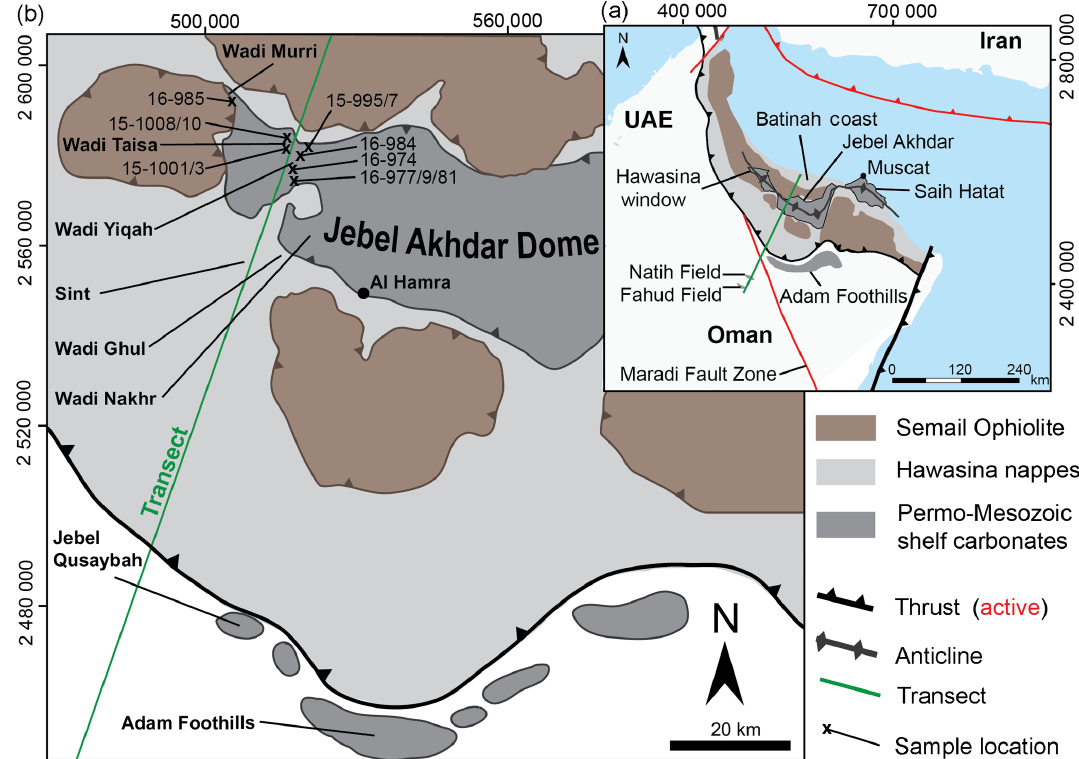
Figure 1. (a) Tectonic setting of the Oman mountains. In dark gray are the three tectonic windows of Hawasina, Jebel Akhdar, and Saih Hatat, as well as the Adam Foothills. Brown areas show the exposed Semail Ophiolite, black lines denote the obduction fronts of Semail and Masirah ophiolites, and red lines denote lithosphere-scale active faults. The modeled transect (black line) crosscuts the Jebel Akhdar window and continues to the Natih and Fahud oil fields in the southwestern mountain foreland. (b) Geologic map of the Jebel Akhdar window with the location of the modeled transect (solid black line) and the locations of thermal maturity data (x).